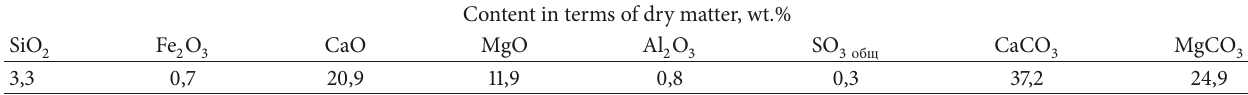
Table 4: Chemical composition of the “Bianca gravel factory” gravel. Content in terms of dry matter,